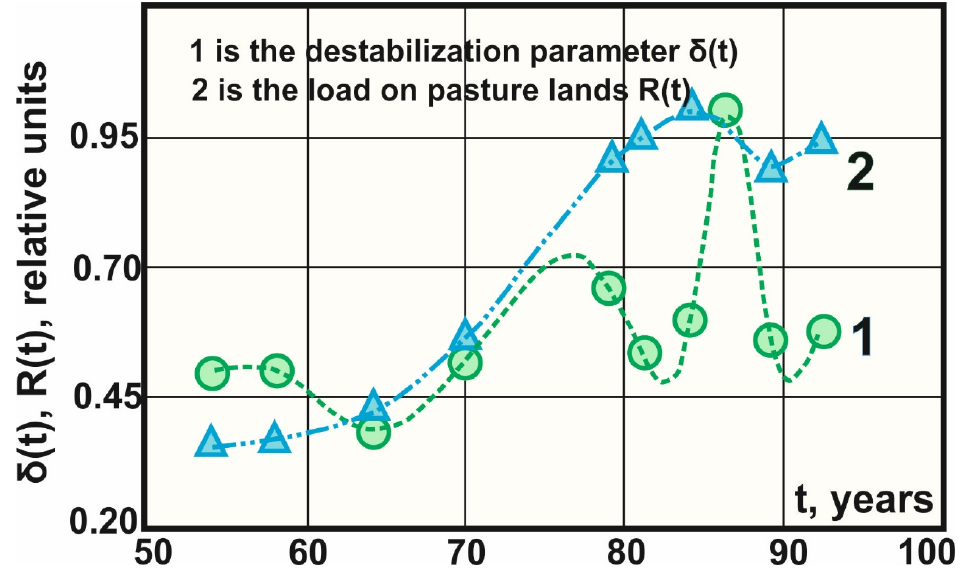
Figure 3. Polynomial regression of time dependencies.